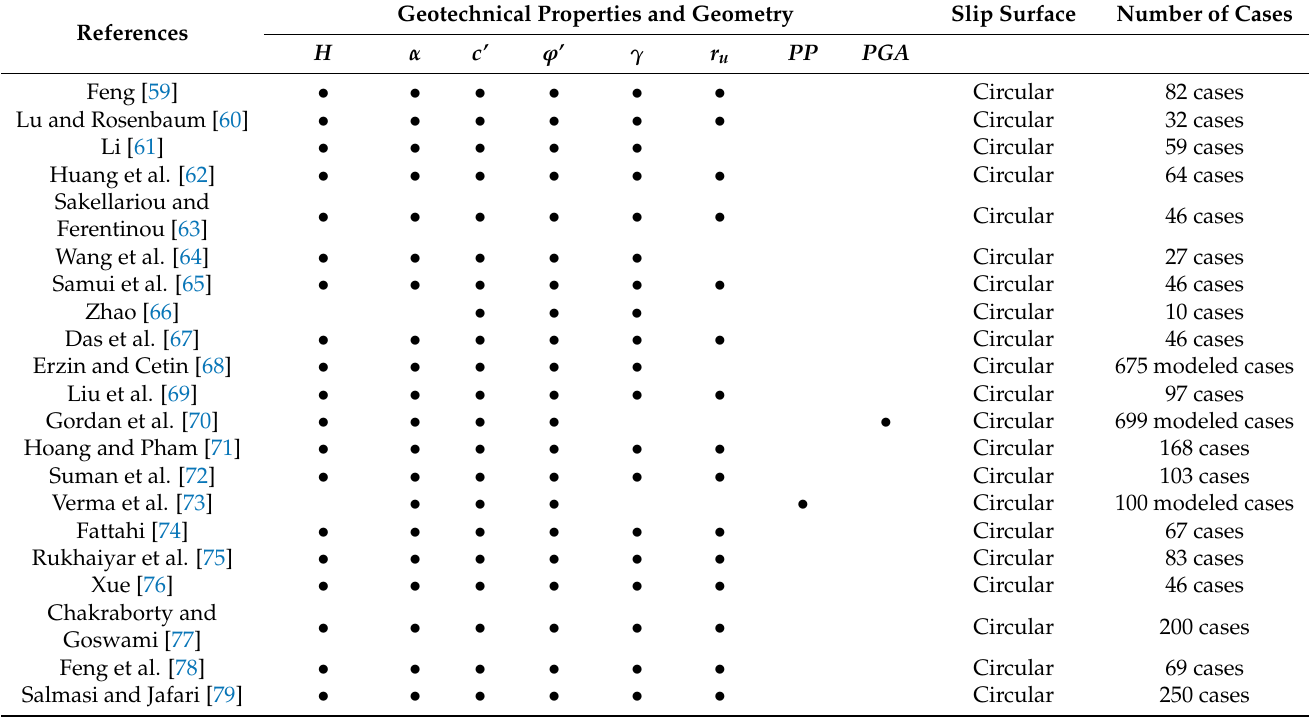
Table 1. Literature review of machine learning techniques applied to slope stability problems.